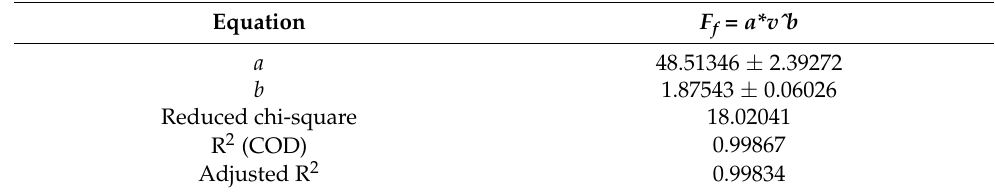
Figure 22. Fitting curve of the relationship between F f and V n. Table 7. Fitting curve equation of the relationship between F f and V